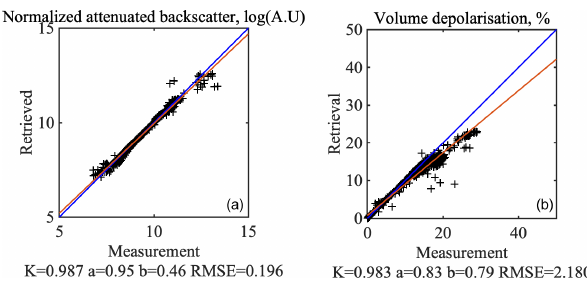
Figure 10. Achieved attenuated normalized backscatter (a) and vol- ume depolarization (b) fits for the multi-temporal retrievals per- formed on 5, 11 August 2015 and 12 August